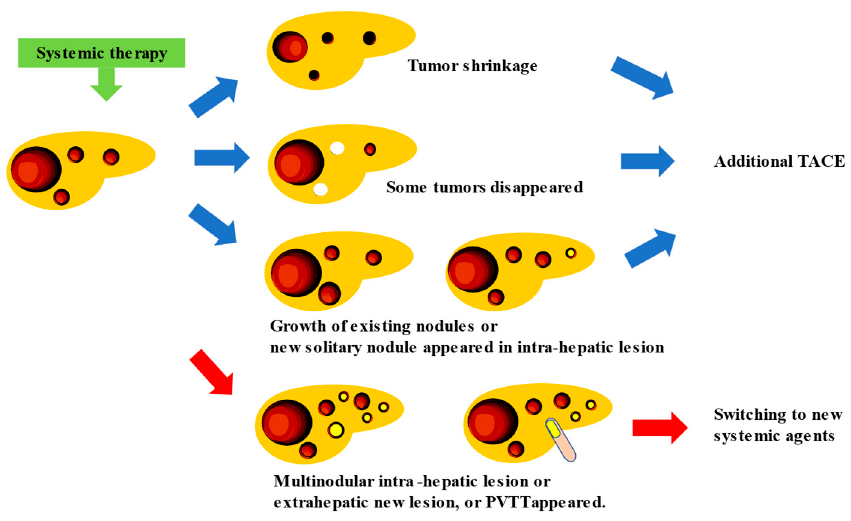
Figure 2. Proposal for the timing of additional TACE treatment for intermediate-stage HCC patients receiving systemic therapy. White tumors indicated disappeared lesions, and yellow ones showed PD lesions.